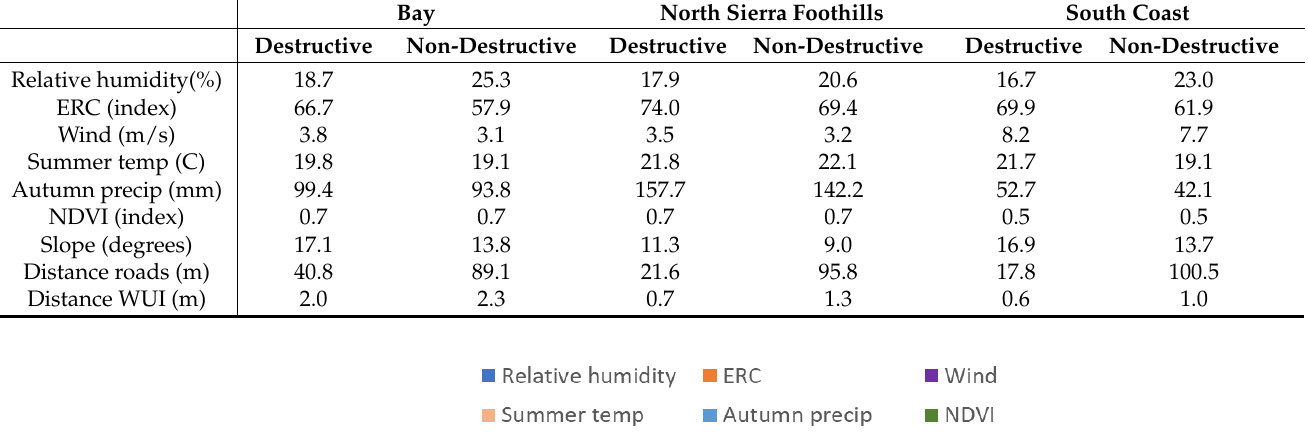
Table 3. Mean values for explanatory variables in models distinguishing destructive and non-